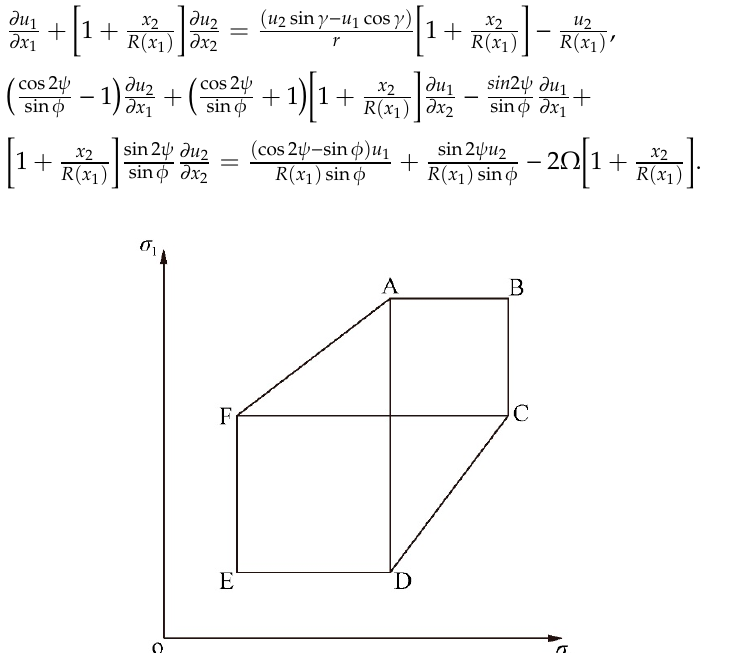
Figure 4. Mohr–Coulomb yield locus under axially symmetric conditions.